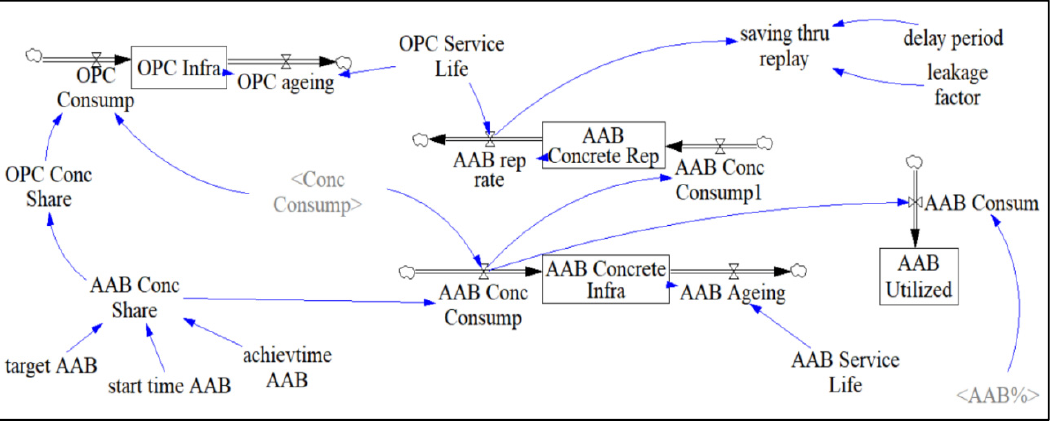
Figure 7. AAB and OPC Concrete Sector.